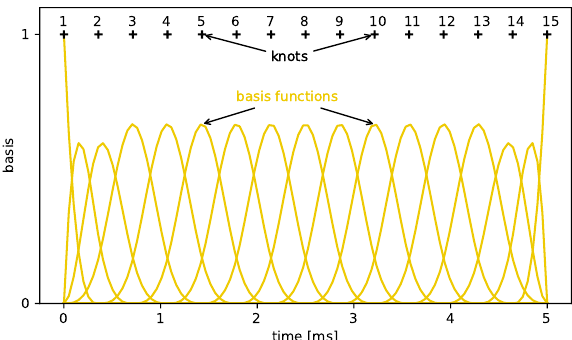
Figure 4. We consider a spline base of 15 third order polynomials. They are all based on equidistant knots and are continuously differentiable except at the